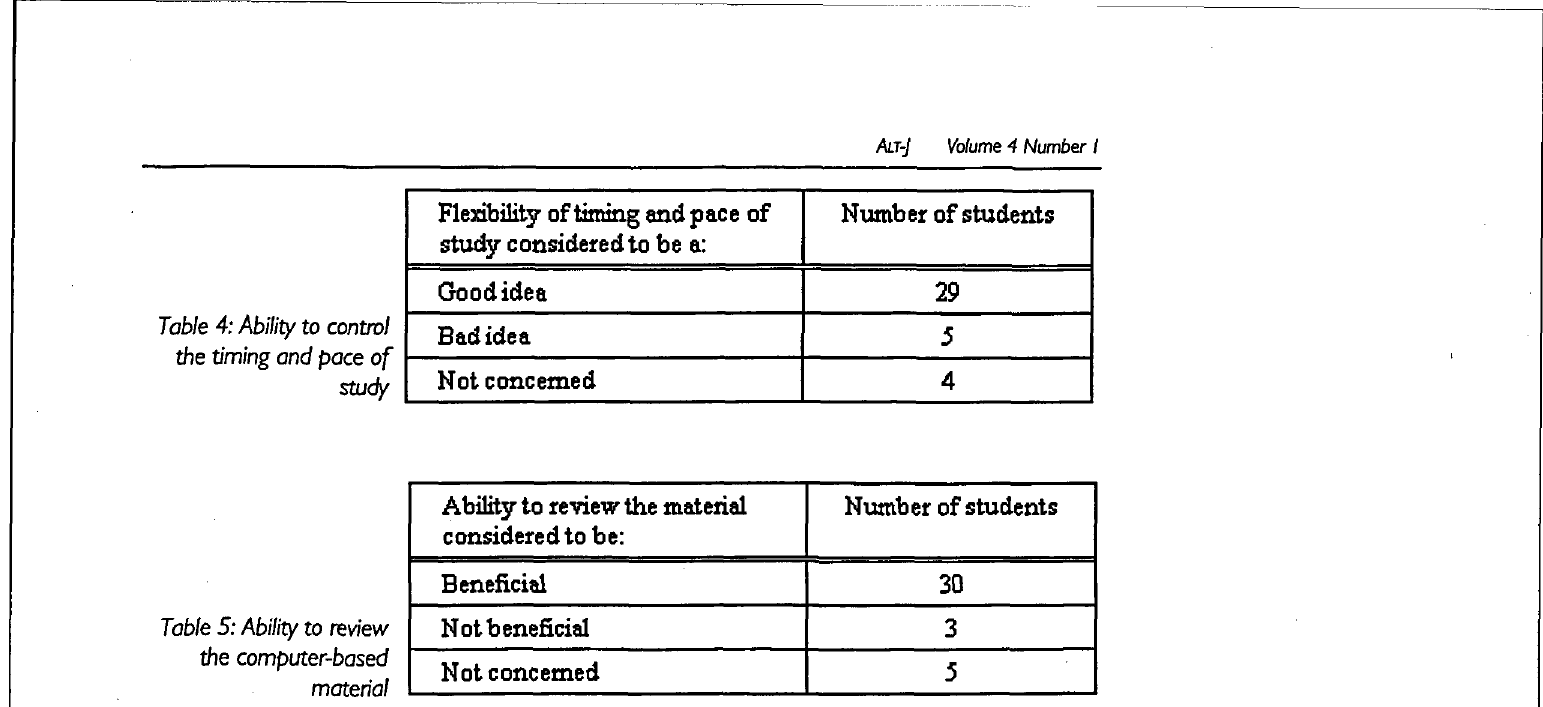
Table 5: Ability to review the computer-based material